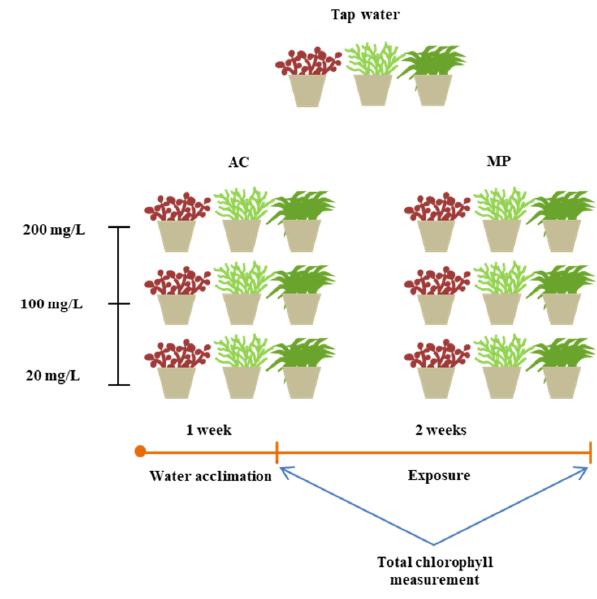
Fig. 1. Experimental setup for acute tolerance